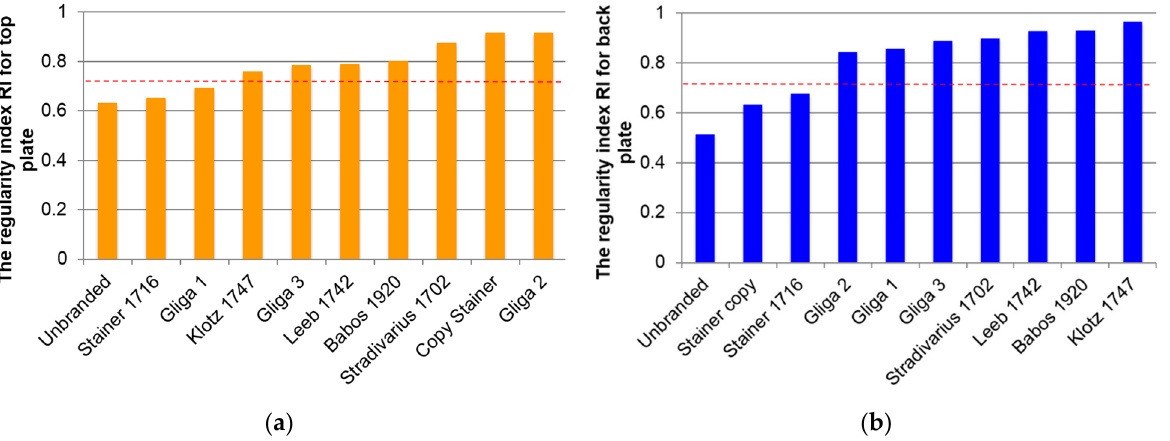
Figure 7. Variation of the regularity index: ( a ) for spruce wood from top plates; ( b ) for maple wood from back plates of studied violins.